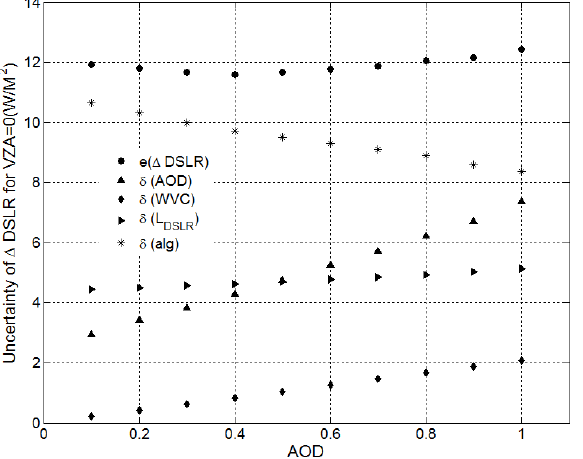
Figure 10. The aero DSLR error caused by uncertainties of thermal channels, AOD, WVC and the Figure 10. The DSLR aero error caused by uncertainties of thermal channels, AOD, WVC and the DSLR accuracy of the DSLR aero − free model for VZA = 0 ◦ and surface altitude z = 0 accuracy of the aero free  model for VZA = 0° and surface altitude z = 0 km.